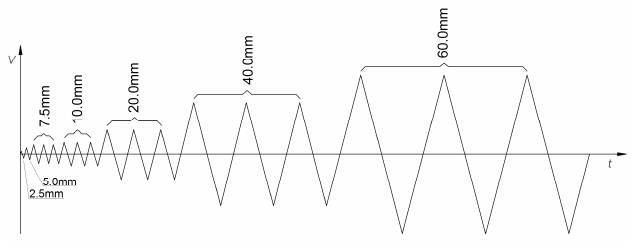
Figure 6. Adopted test protocol according to EN 12512 [17].